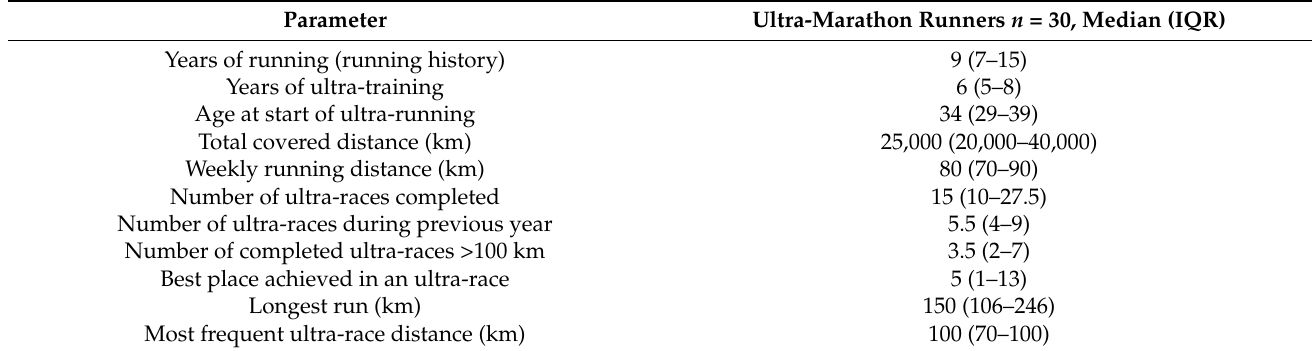
Table 1. Characteristics of ultra-marathon runners.